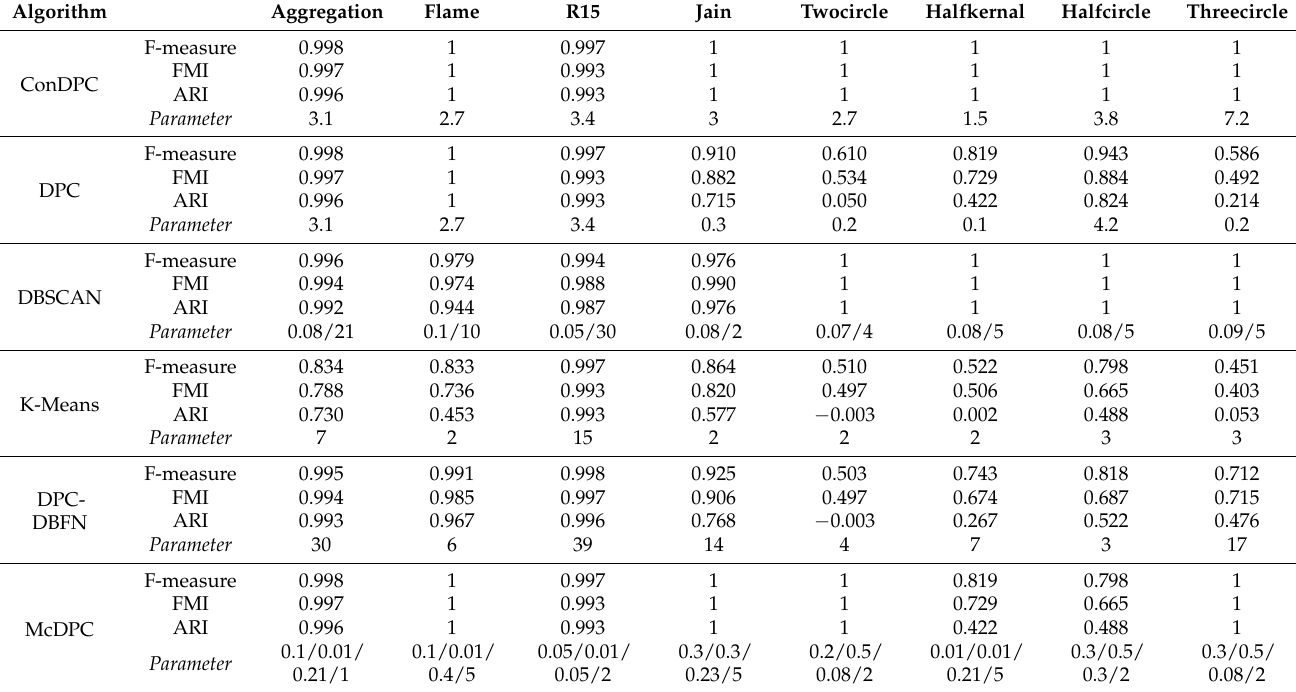
Table 3. Performances on synthetic datasets.